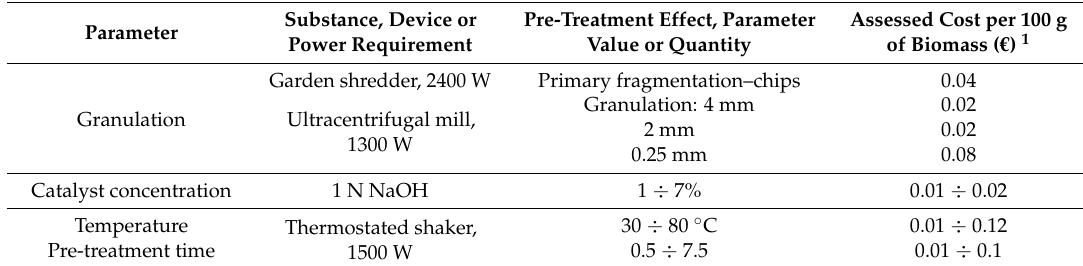
Table 8. Cost assessment of alkaline pre-treatment.